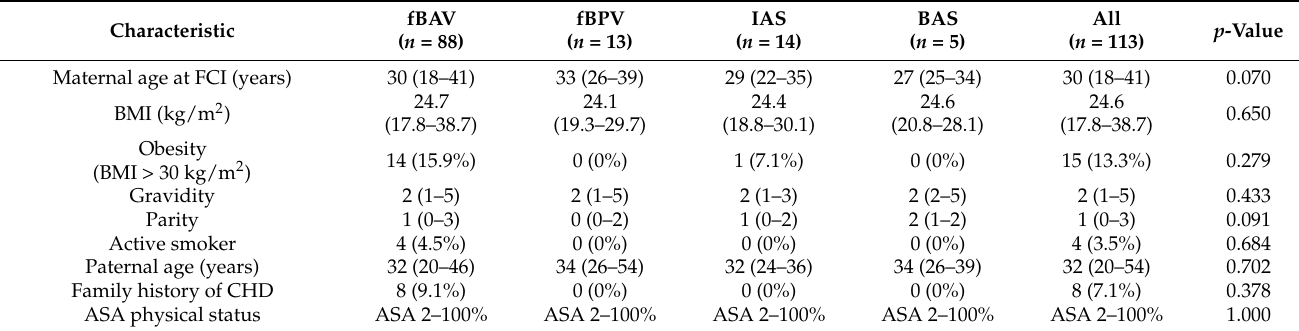
Table 1. Characteristics of the patients who underwent fetal FCI according to the type of